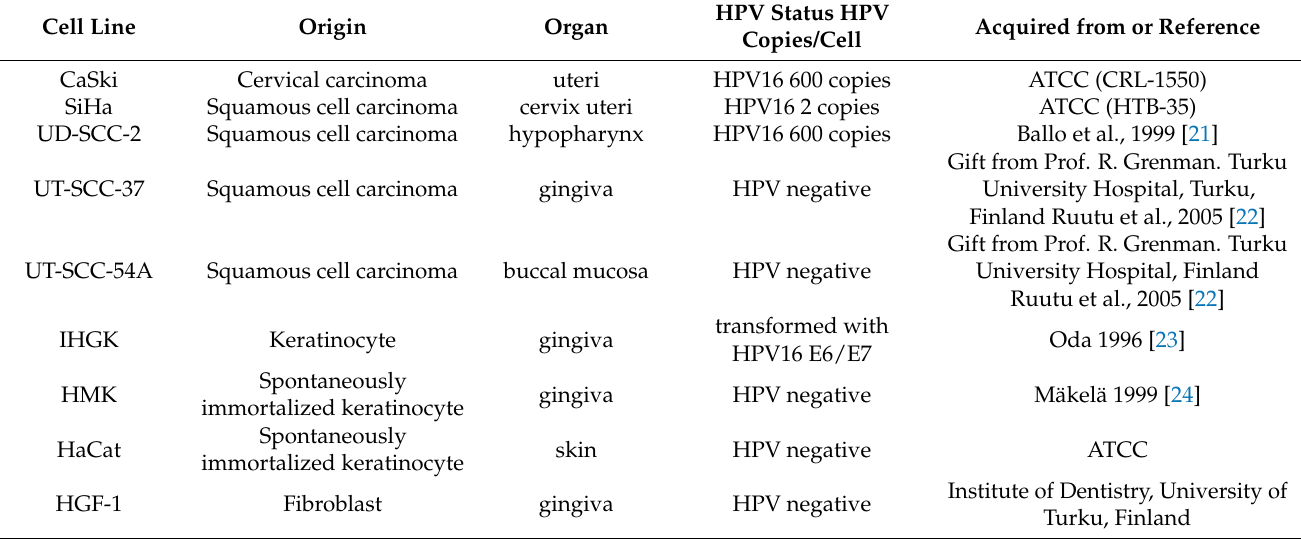
Table 1. The human papillomavirus positive (CaSki, SiHa and UD-SCC-2) and negative (UT-SCC-37 and UT-SCC-54A) carcinoma and immortalized cell lines (IHGK, HMK, and HaCat) were used in the present study. Normal fibroblasts established from gingiva (HGF-1) served as the